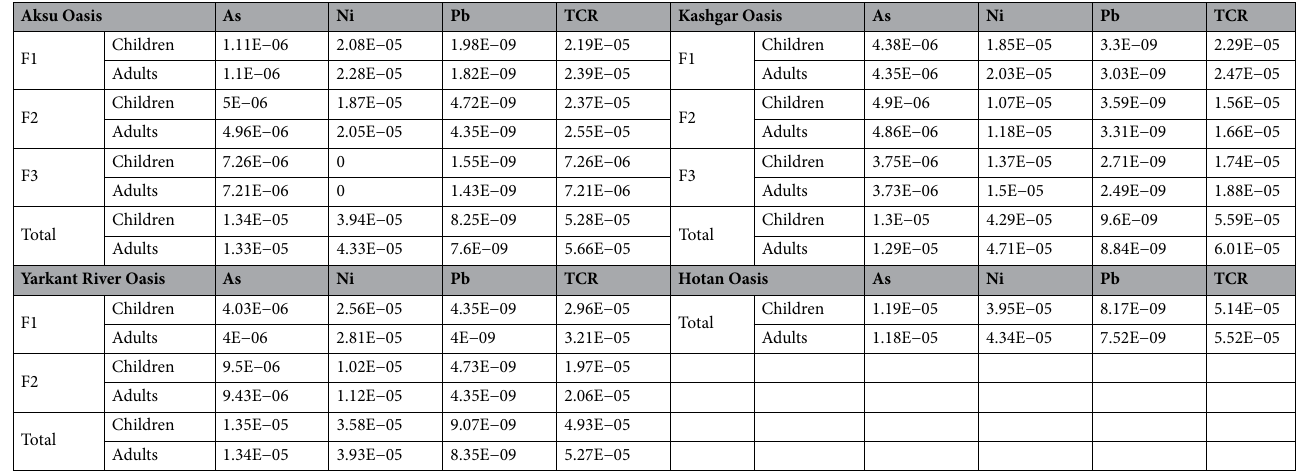
Table 5. Specific carcinogenic risks of PTEs from different